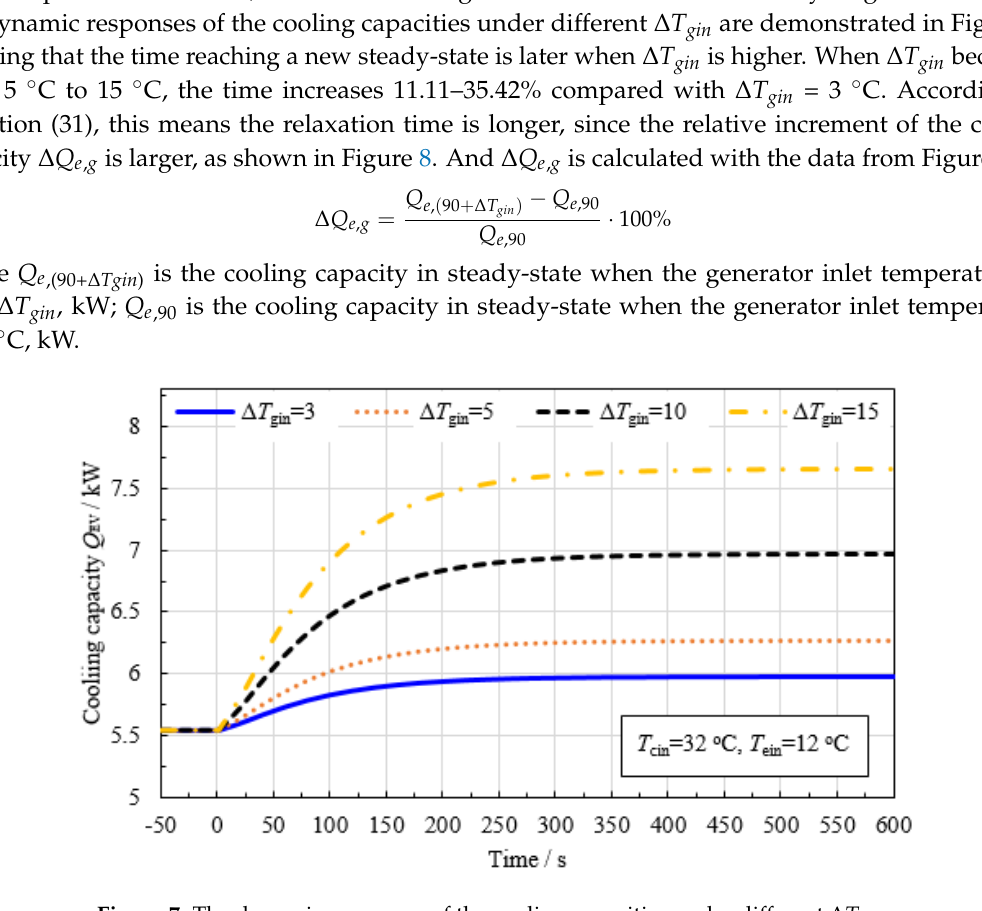
Figure 7. The dynamic responses of the cooling capacities under different Δ T gin .